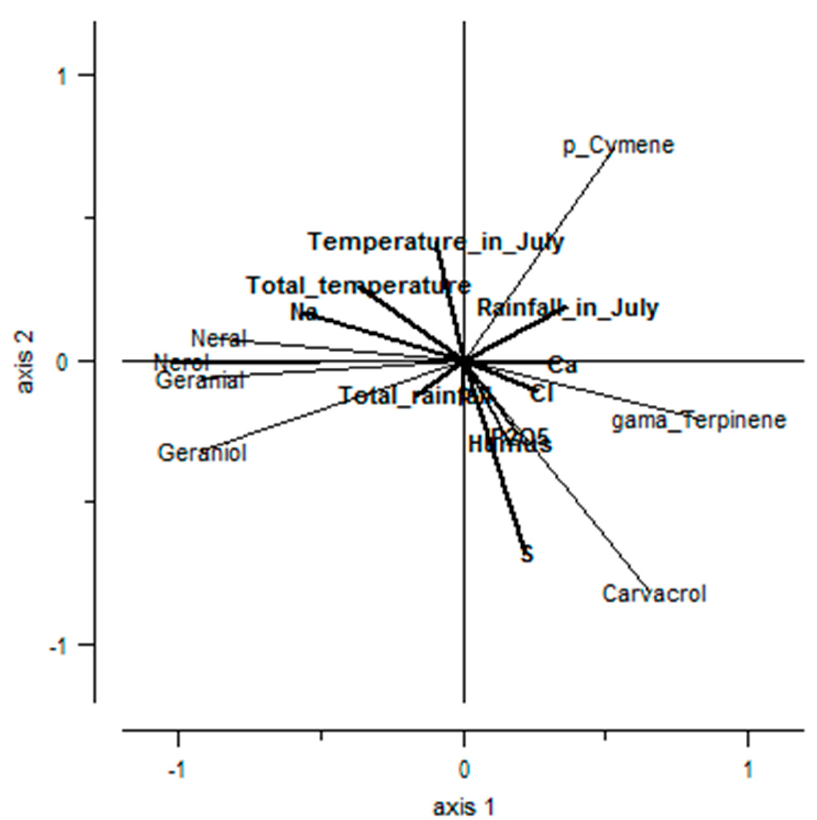
Figure 7. Dependence of the amounts of Thymus pulegioides geraniol and carvacrol chemotype-determining compounds in essential oils on edaphic and climatic factors (redundancy analysis).